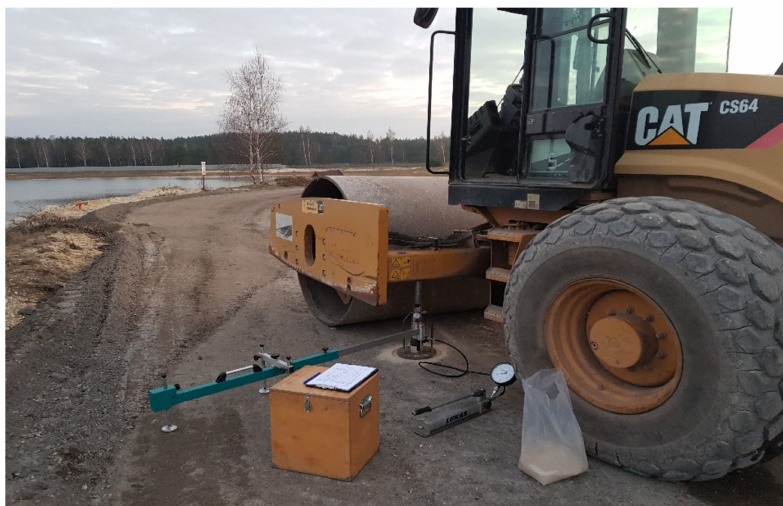
Figure 9. Measurement of base course bearing capacity in the field (J.